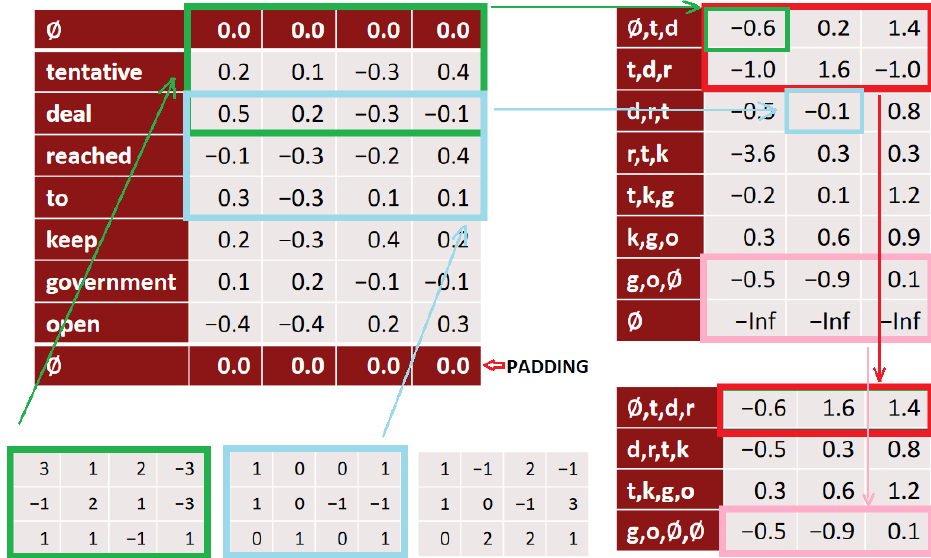
Figure 5. The process of 1D convolution with 3 filters and a pooling layer [23].